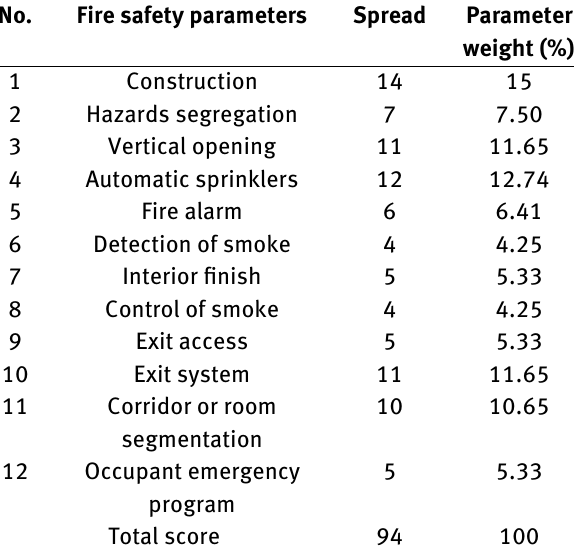
Table 1: Fire safety risk predection parameter [14]